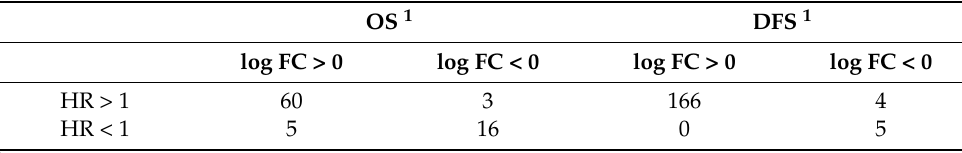
Table 1. The data of OS and DFS in terms of log FC and